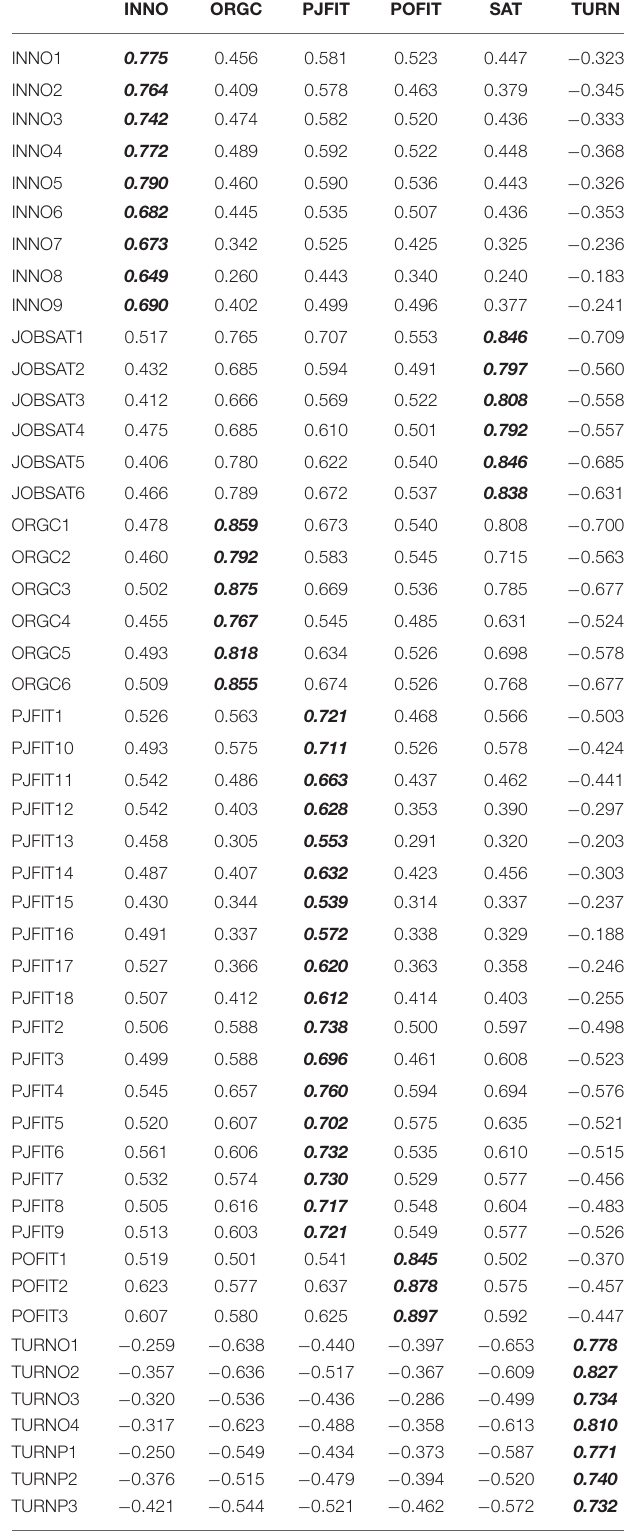
The bold values are standardized factor loadings and other values are cross loadings for each